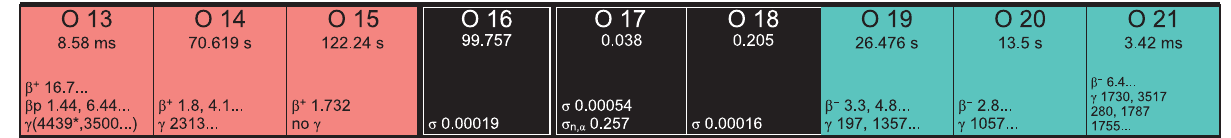
Fig. 6. The element oxygen (O) has 15 isotopes in the 10th edition of the Karlsruhe Nuclide Chart. In the above fi gure, 9 of these isotopes are shown. The three stable isotopes: O 16, O 17 and O 18 are shown in black. The natural isotopic abundances are respectively: 99.757, 0.038 and 0.205 atom %.